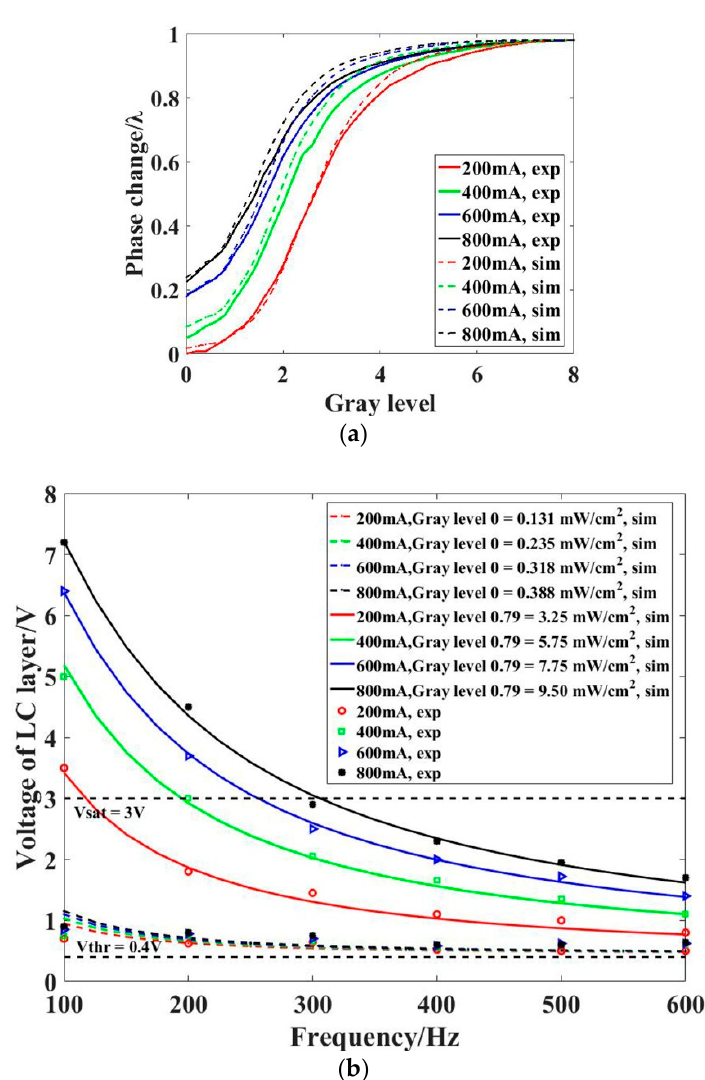
Figure 4. ( a ) Drive current of the write light affects the peak-to-valley (PV) value of the phase change when the OALCLV is at a (cid:1848) (cid:3002)(cid:3004) value of 14 V at 100 Hz. ( b ) The voltage on the LC layer of the OALCLV as determined by the drive current of the write